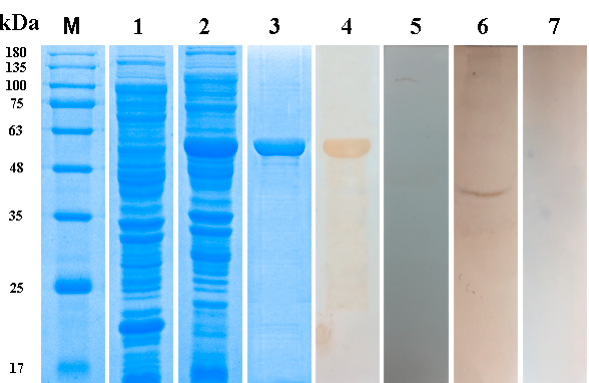
Figure 4. Purification and Western blotting of recombinant rTmAnxB2. M, Protein markers; 1, pET32a-vector; 2, pET32a-TmAnxB2; 3, Purified rTmAnxB2; 4, rTmAnxB2 detected by T. multiceps -positive goat serum; 5, rTmAnxB2 detected by T. multiceps -negative goat serum; 6, Western blot of T. multiceps extracts detected by rabbit anti-rTmAnxB2-IgG; 7, Western blot of T. multiceps extracts detected by healthy rabbit serum (controls).